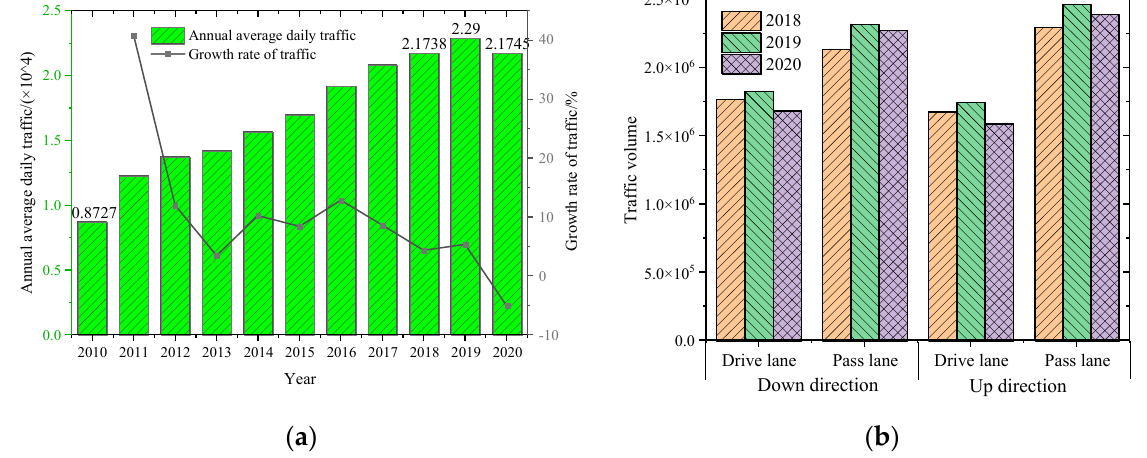
Figure 4. Analysis of traffic volume: ( a ) variation in traffic volume; ( b ) direction distribution in traffic.